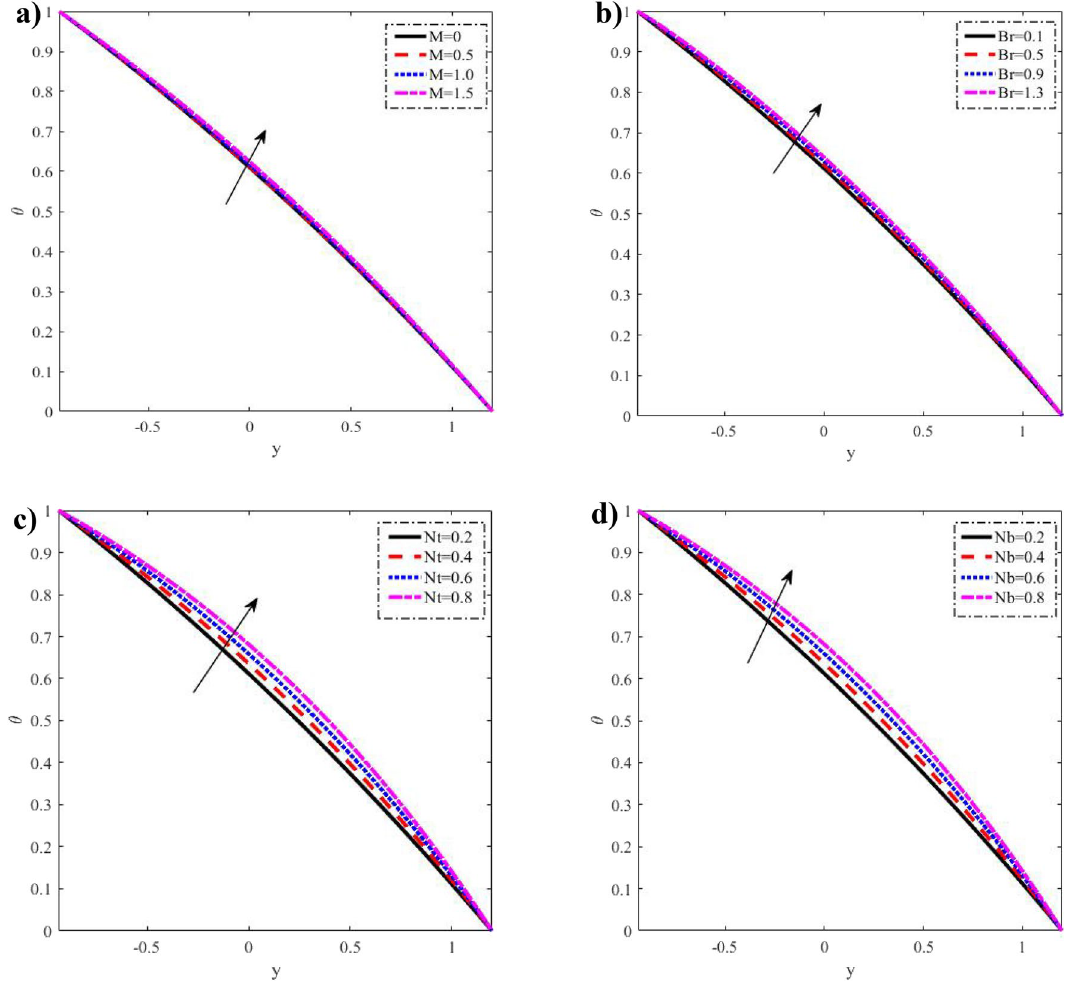
Figure 3. Discrepancies of the temperature θ against the y-axis. ( a ) For different values of M . ( b ) For different values of Br . ( c ) For different values of Nt . ( d ) For different values of Nb